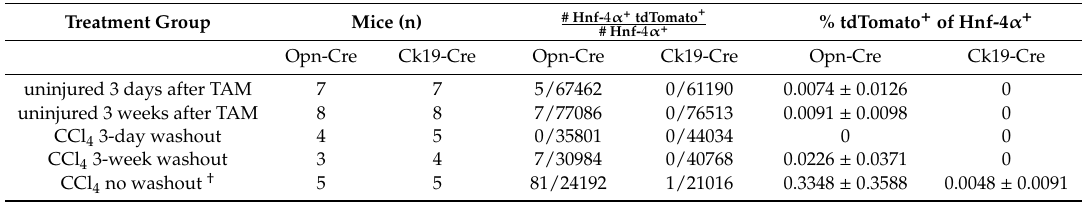
Table 2. Quantification of tdTomato + hepatocytes.